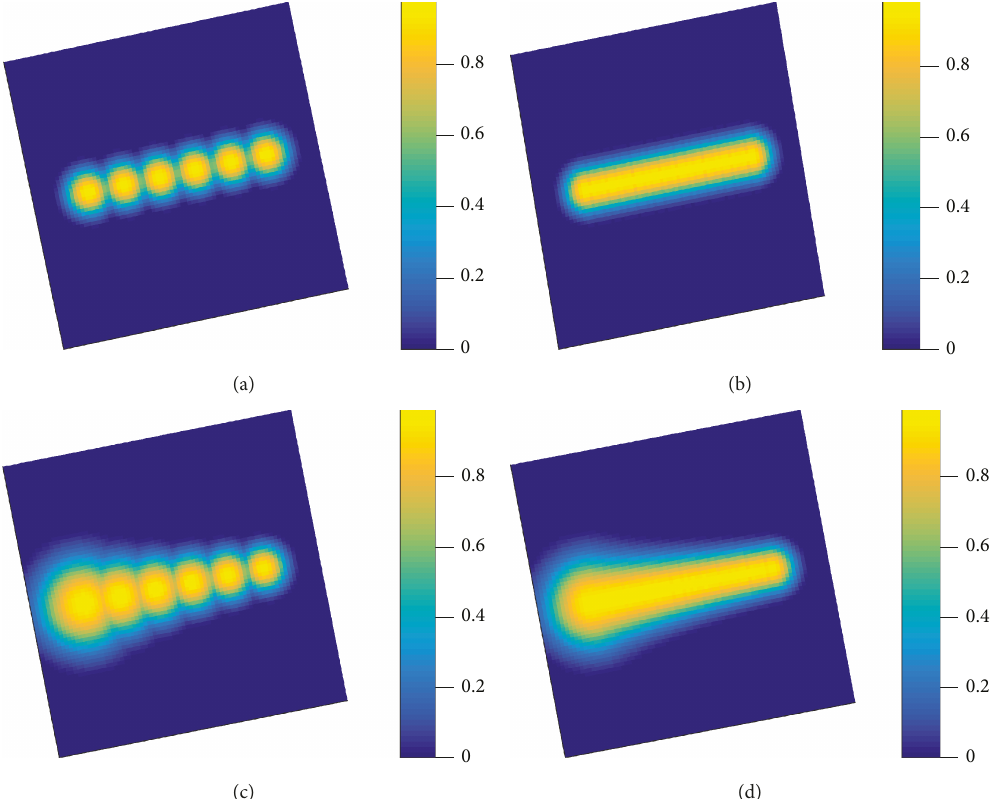
Figure 2: Stick primitives obtained with n = 6 and 20: constant radius (a, b); variable radius (c, d). The stick support becomes more regular blob ; the strength fi eld remains bounded to the unit increasing n blob